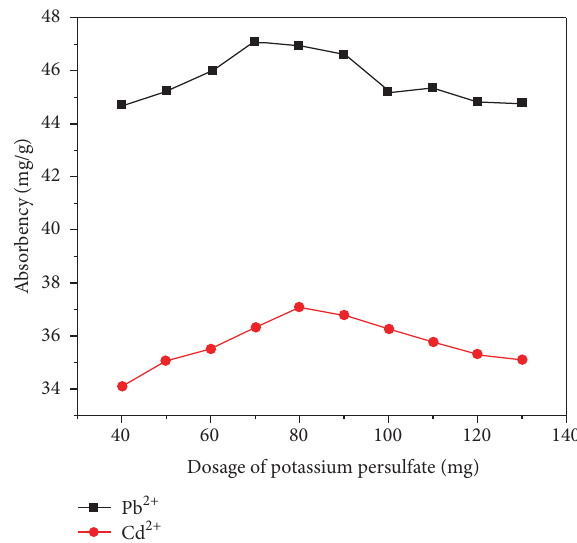
Figure 1: Effect of potassium persulfate amount on Pb 2+ and Cd 2+